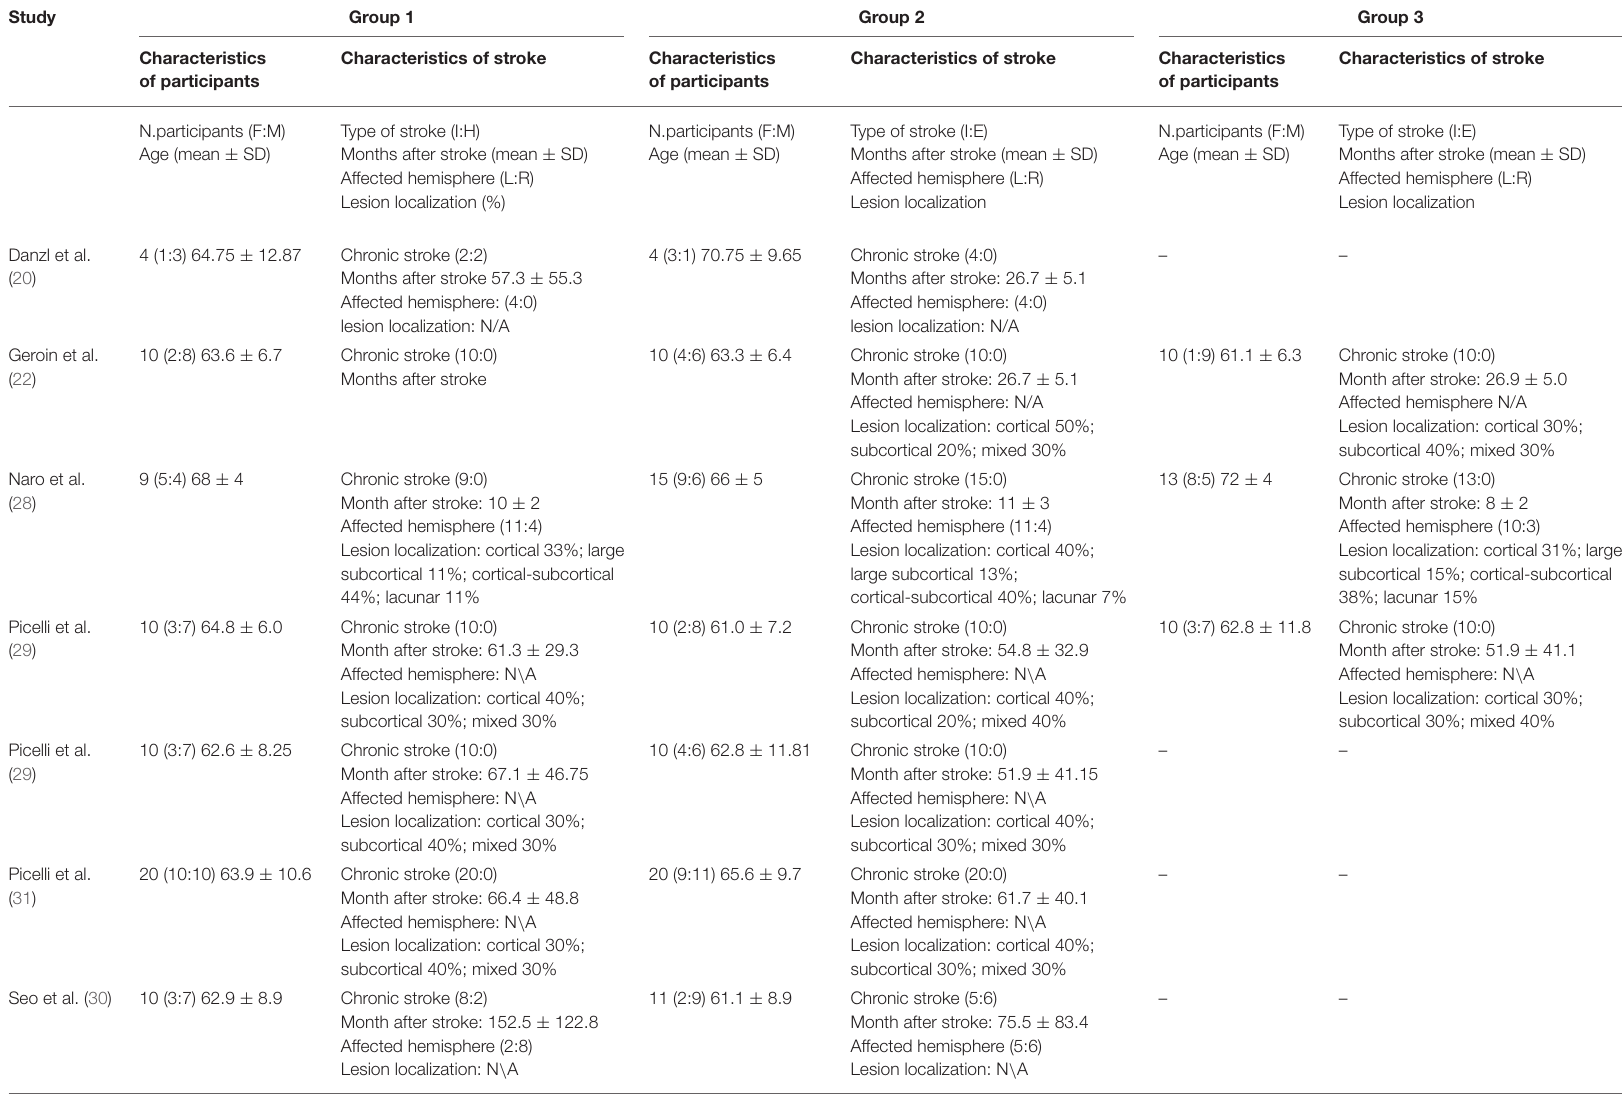
TABLE 3 | Characteristics of the